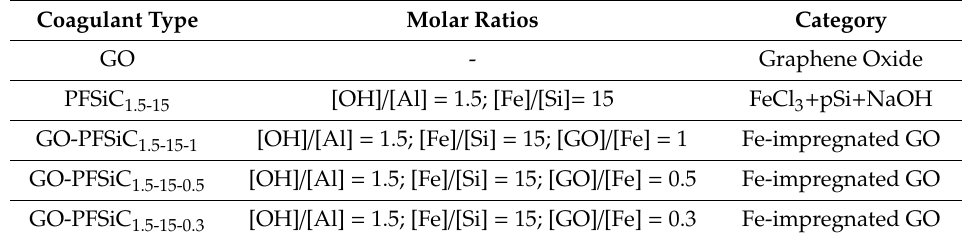
Table 1. Preparation conditions for the laboratory-synthesized composite coagulant agents, examined in this study.